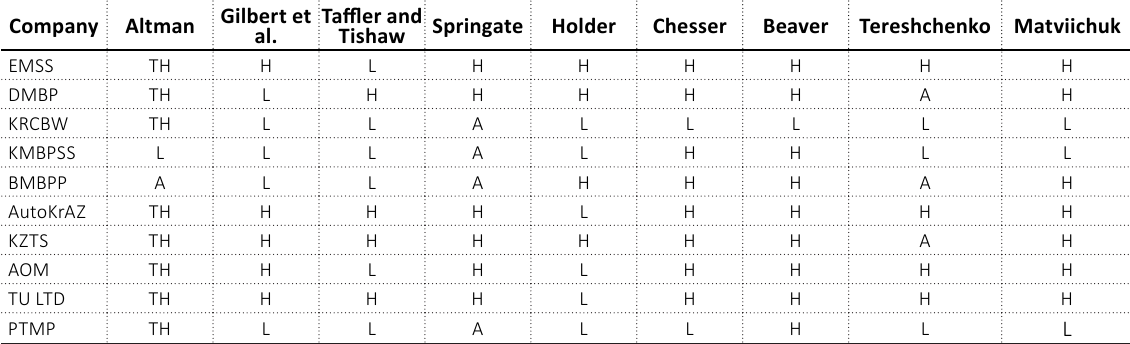
Table 1. Summary of business assessment results*